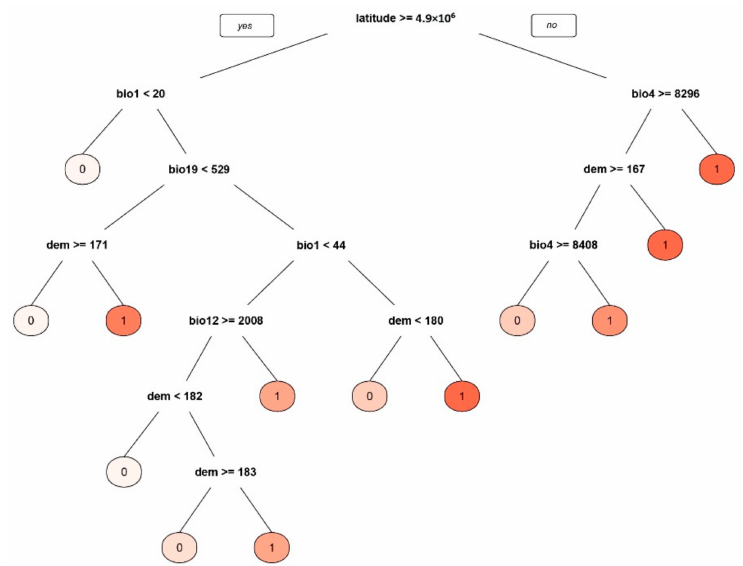
Figure 2. Classification tree describing the relationships between the predictors and parasite presence. Models are read from the top down beginning at the root node, which contains all data. At each subsequent decision node, data that satisfies the splitting rule moves to the left branch and all other data moves to the right branch. Observations in terminal nodes are classed as present (1) or absent (0).